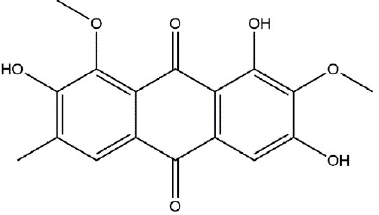
Figure 1. The chemical structure of aurantio-obtusin.